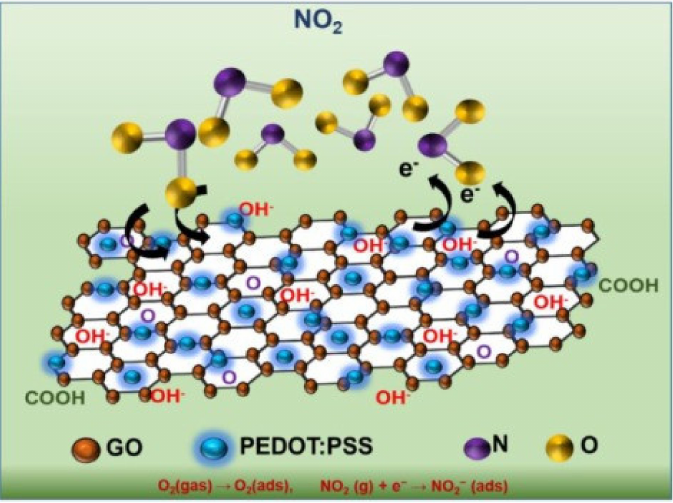
Figure 5. Sensing mechanism of GO − PEDOT:PSS under NO 2 gas ambient. Reprinted with permis- sion from Ref. [31]. Copyright 2021